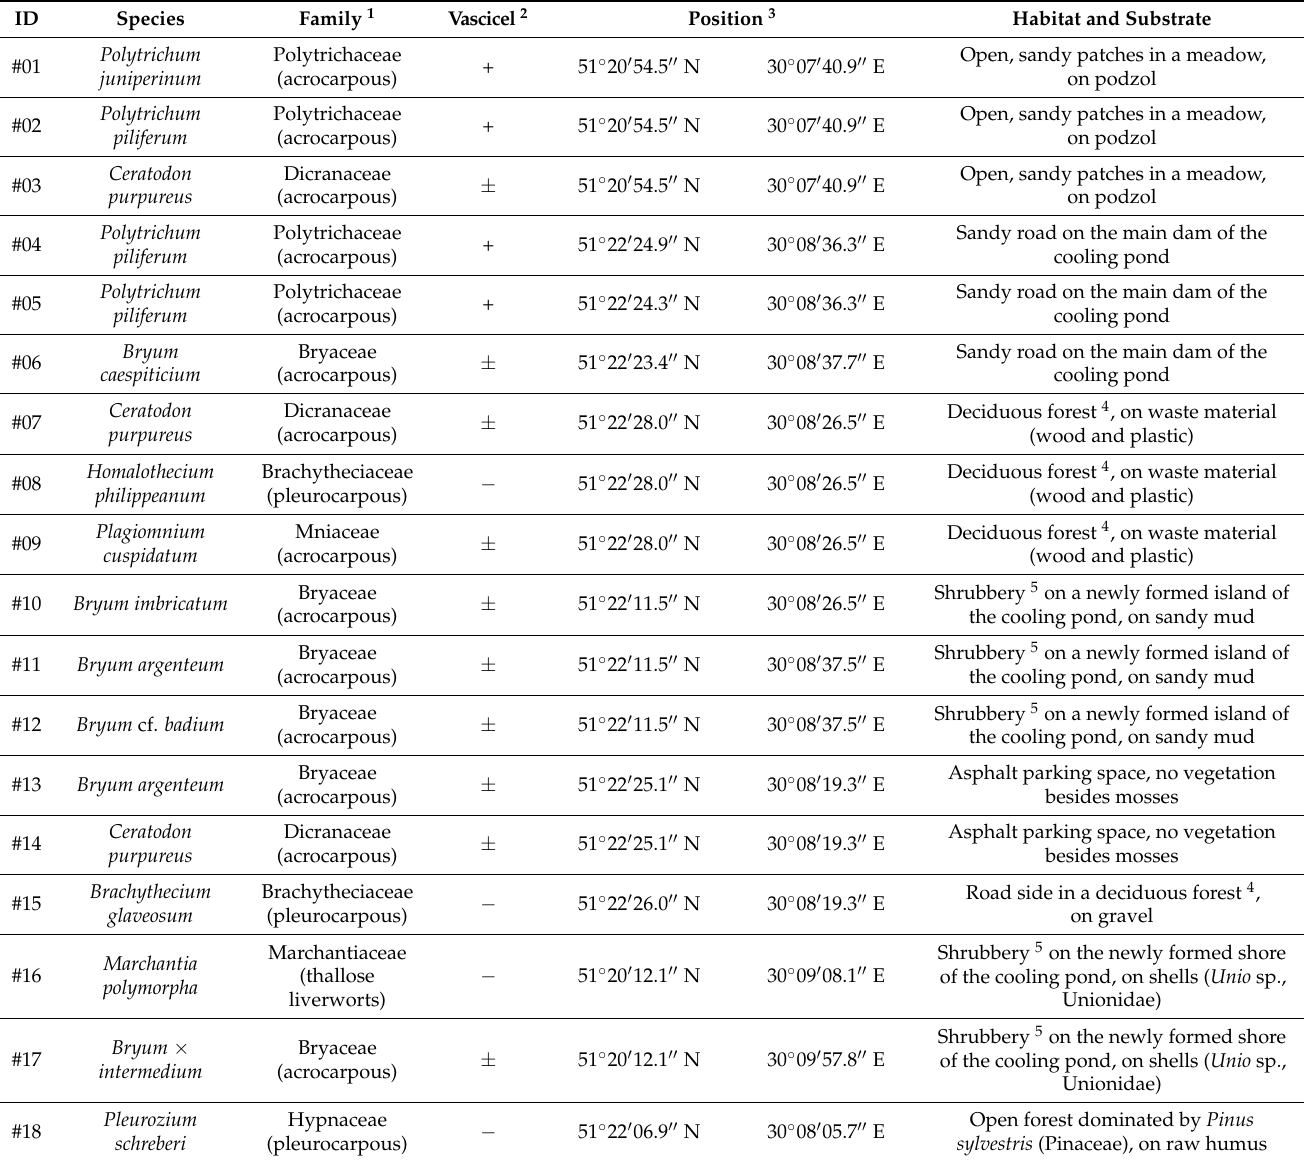
Table 1. Principal characteristics of the Bryophytes used in this study: # indicates the sampling location as described in Figure